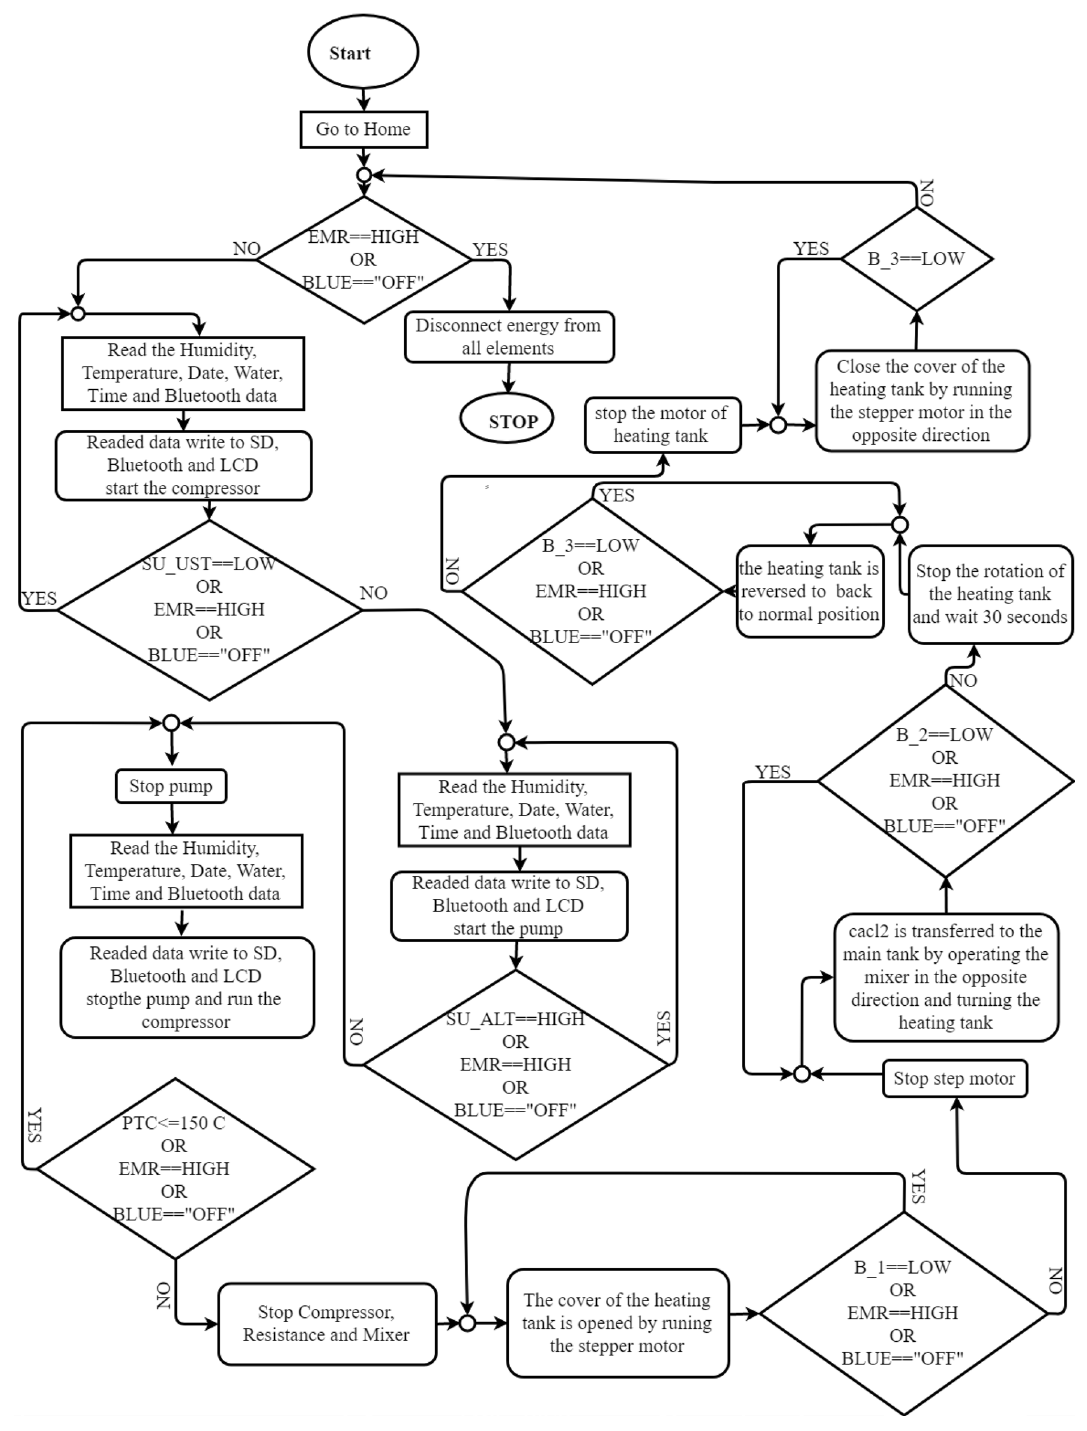
Fig. 4 Working move up until the cover contacts the limit switch. Then, the mixer runs in the opposite direction and the turning process continues until the heating tank is turned and the button in the salt and air absorbing tank is activated. The waiting time 1 3